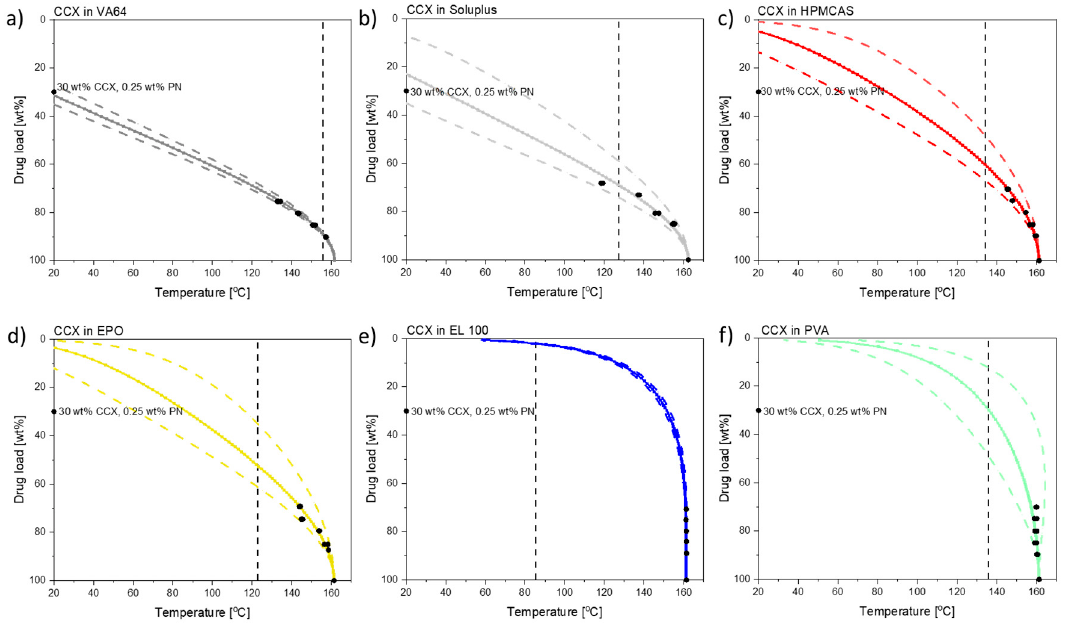
Figure 1. Drug–polymer solubility curves: ( a ) CCX in VA64; ( b ) CCX in Soluplus [20]; ( c ) CCX in HPMCAS; ( d ) CCX in EPO; ( e ) CCX in EL100; and ( f ) CCX in PVA. The black dots indicate the data points used for the calculations and the chosen drug load of 30 wt% used in this study. The vertical black dashed lines indicate the average maximum temperature ( T max ) achieved during the longest exposure to laser radiation.